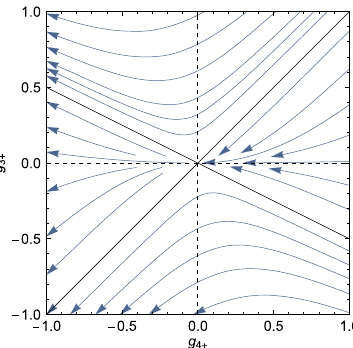
FIG. 11. Energy contour plots of the energy bands ϵ τ k , Eq. (E3). Panels (a) and (b) correspond to the energy dis- ; g 3 persions of the two different valleys. The parameters are chosen FIG. 10. RG flows on the ð g 4 Þ plane without Fermi þ þ as t 0 ¼ 5 . 4 , t 1 ¼ 1 , t 2 ¼ − 1 , t 0 2 ¼ 0 . 3 , and t 3 ¼ 0 . 6 . The Lifshitz surface nesting other than the BCS channel. Black solid lines are transition and accompanying VHS are found at E=t 1 ≈ 6 . 1 . The the separatrix lines of the flows. One finds the same RG flow for g 4 − and g 3 − . bandwidth is D ¼ 7 . 2